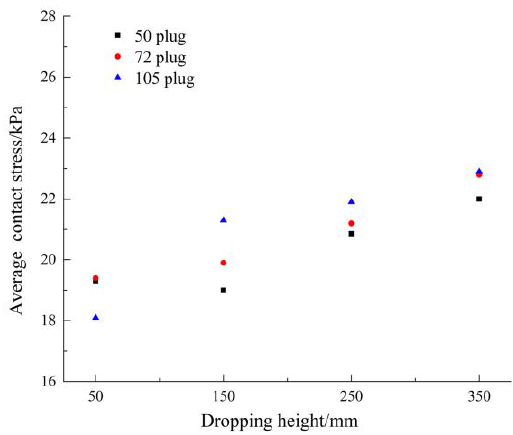
Figure 14. The relationship between the average contact stress and the drop height of the plug seedlings of different plug specifications.